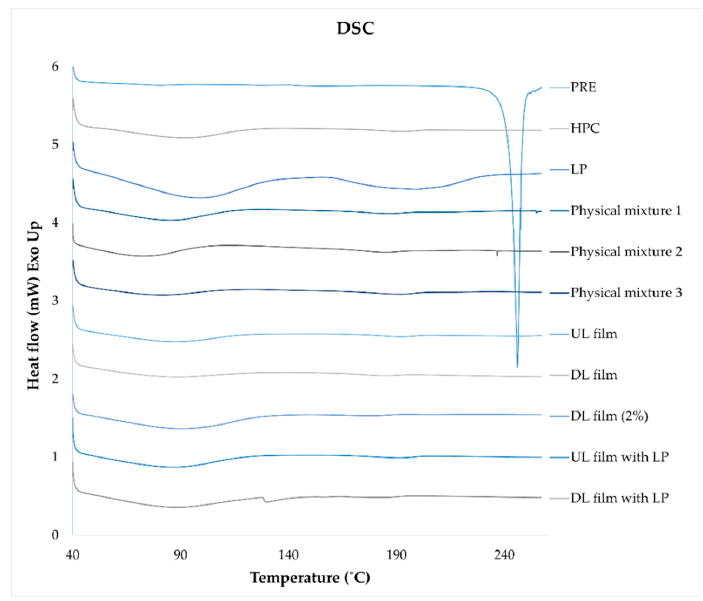
Figure 13. DSC curves of pure substances, physical mixtures, and unloaded and drug-loaded films with and without liver powder. Physical mixture 1 is a mixture of prednisolone and hydroxypropyl cellulose, physical mixture 2 contains all three dry substances (prednisolone, hydroxypropyl cellulose, and liver powder), and physical mixture 3 is a blend of hydroxypropyl cellulose and liver